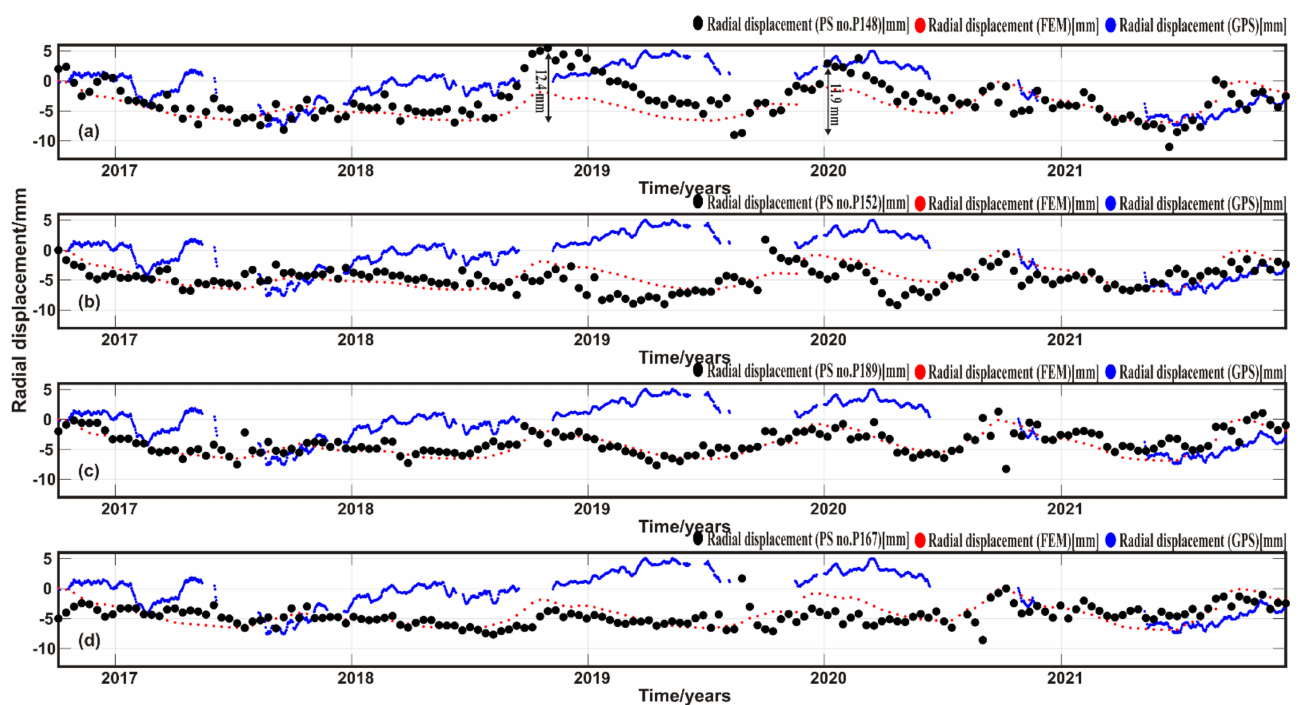
Figure 12. Visual analysis of four InSAR (black dots) radial displacement zones and those obtained with GPS (blue line) and FEM (red dots). ( a ) PS no. P148 located in the central zone of the crest. ( b ) PS no. P152 situated in the center of the crest. ( c ) PS no. P189 located in the western zone of the crest. ( d ) PS no. P167 located in the eastern zone of the crest and close to the GPS